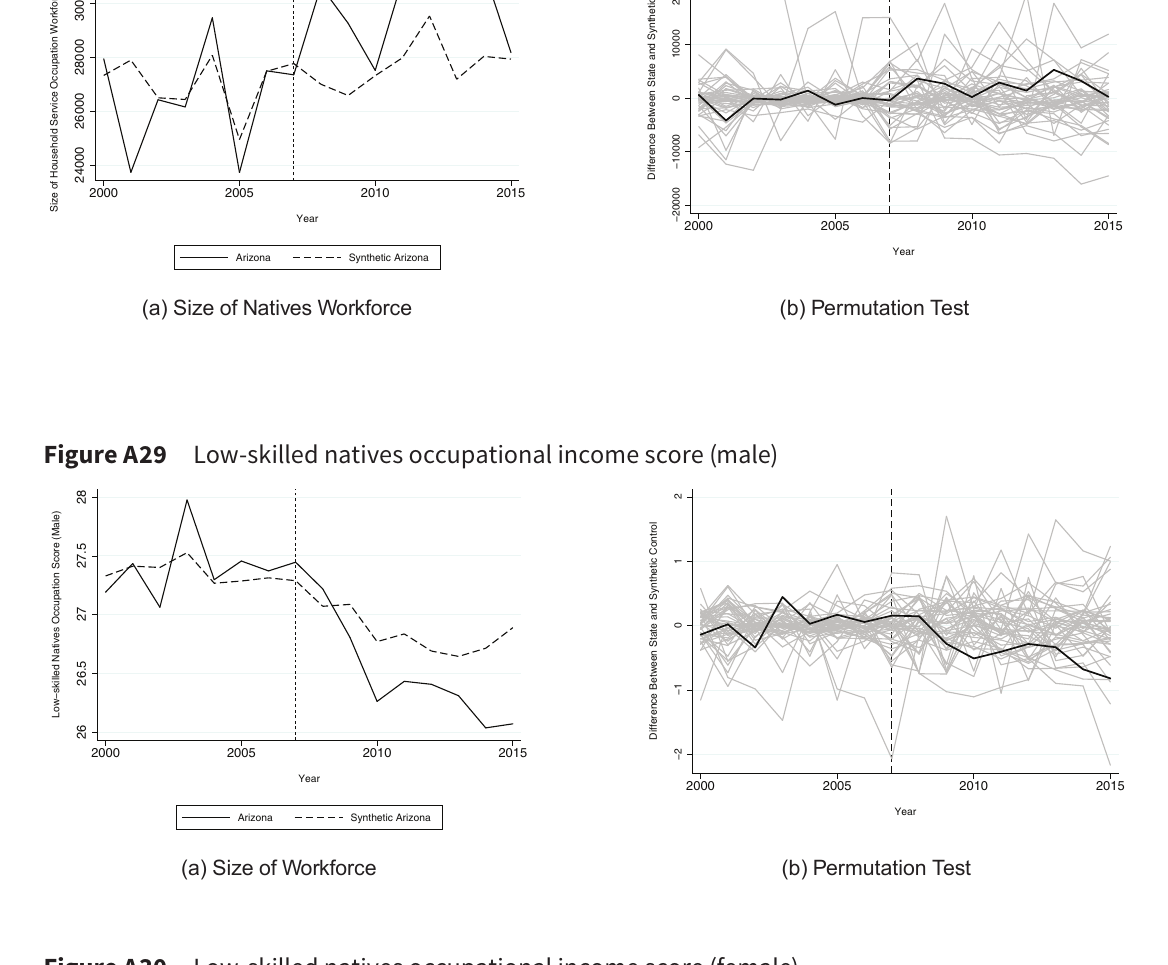
Figure A30 Low-skilled natives occupational income score